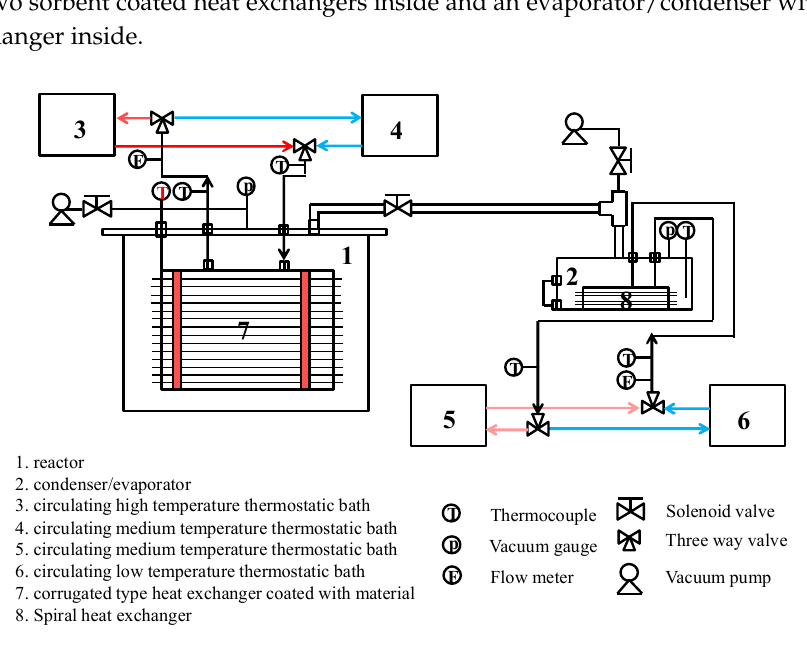
Figure 2. Schematic diagram of experimental setup.